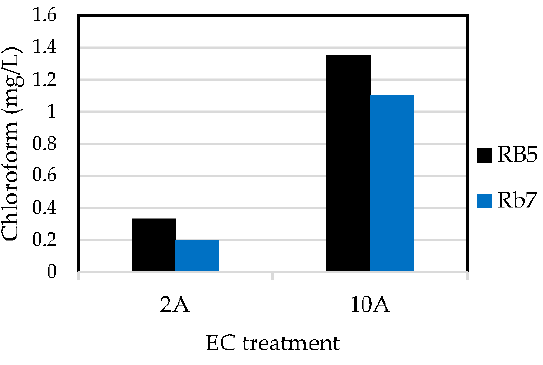
Figure 5. Chloroform generation in the electrochemical treatment (EC) carried out at 2 A and 10 A.